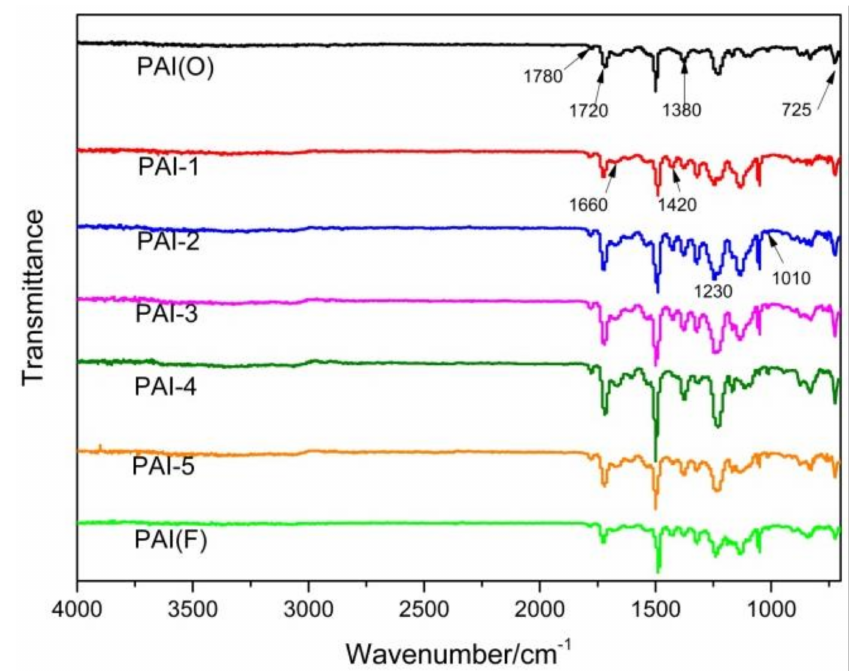
Figure 2. Infrared spectra of PAI